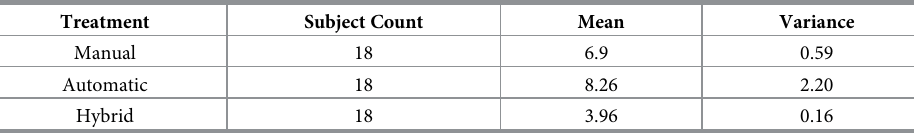
Table 23. Data summary—Viewpoint